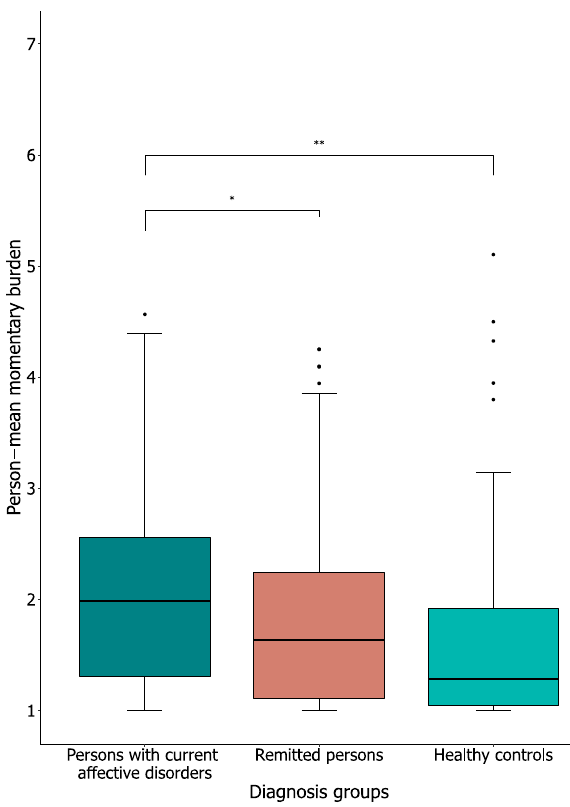
Figure 2. Person-mean momentary burden as reported on the EMA measures. Note: Value labels: 1 = ’No burden’; 4 = ’Moderate burden’; 7 = ’High burden’. Thick black line shows the median, error bars show the interquartile range (IQR), whiskers show +/-1.5 IQR, • = outlier, deviates by ≥ 1.5x IQR, * = significant at p < 0.017 (Bonferroni-adjustment), and ** = significant at p < 0.0001. 3.3. Adherence to the daily EMA questionnaires .